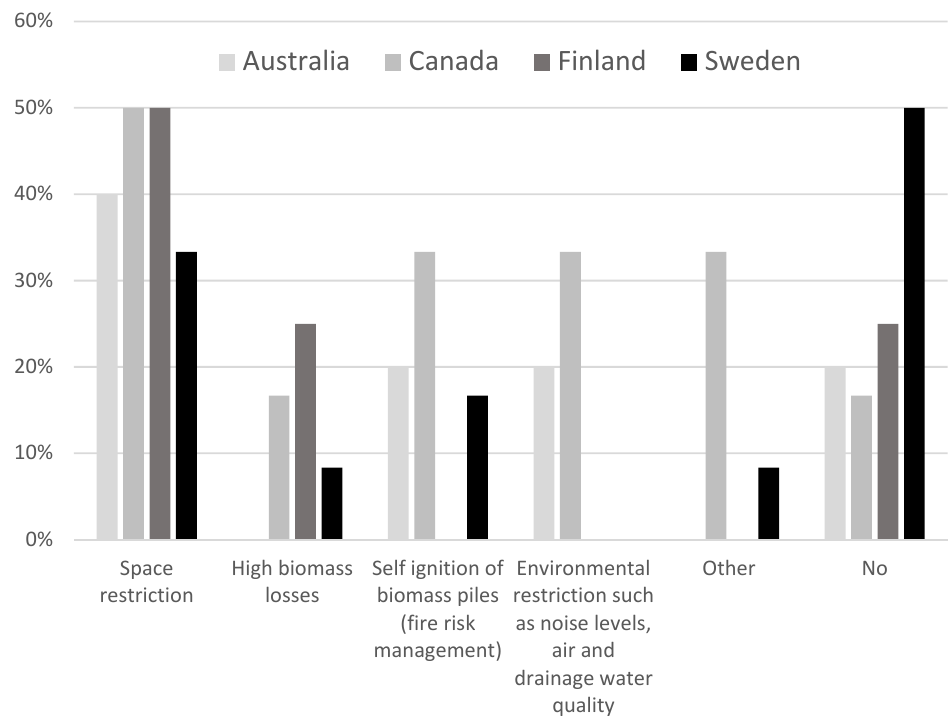
Figure 2. The most common problems associated with biomass storage as reported by the surveyed bioenergy facilities ( n = 27).